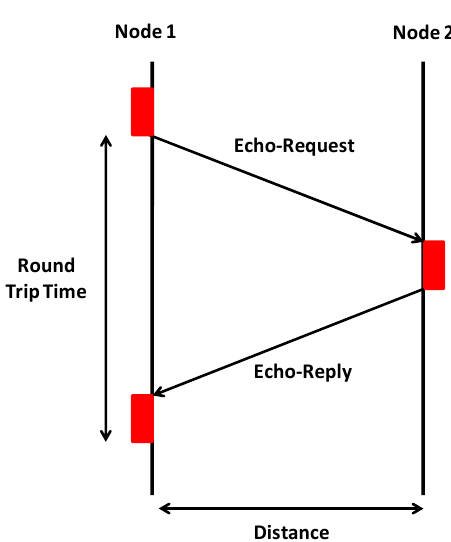
Figure 5. Packet flow diagram.